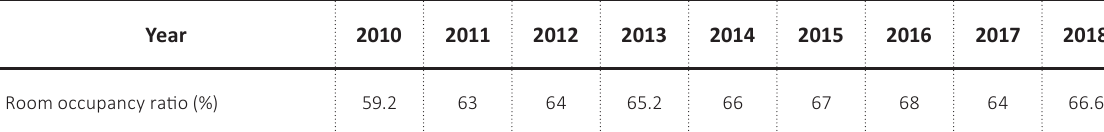
Table A5. Hotel room occupancy in Saudi Arabia